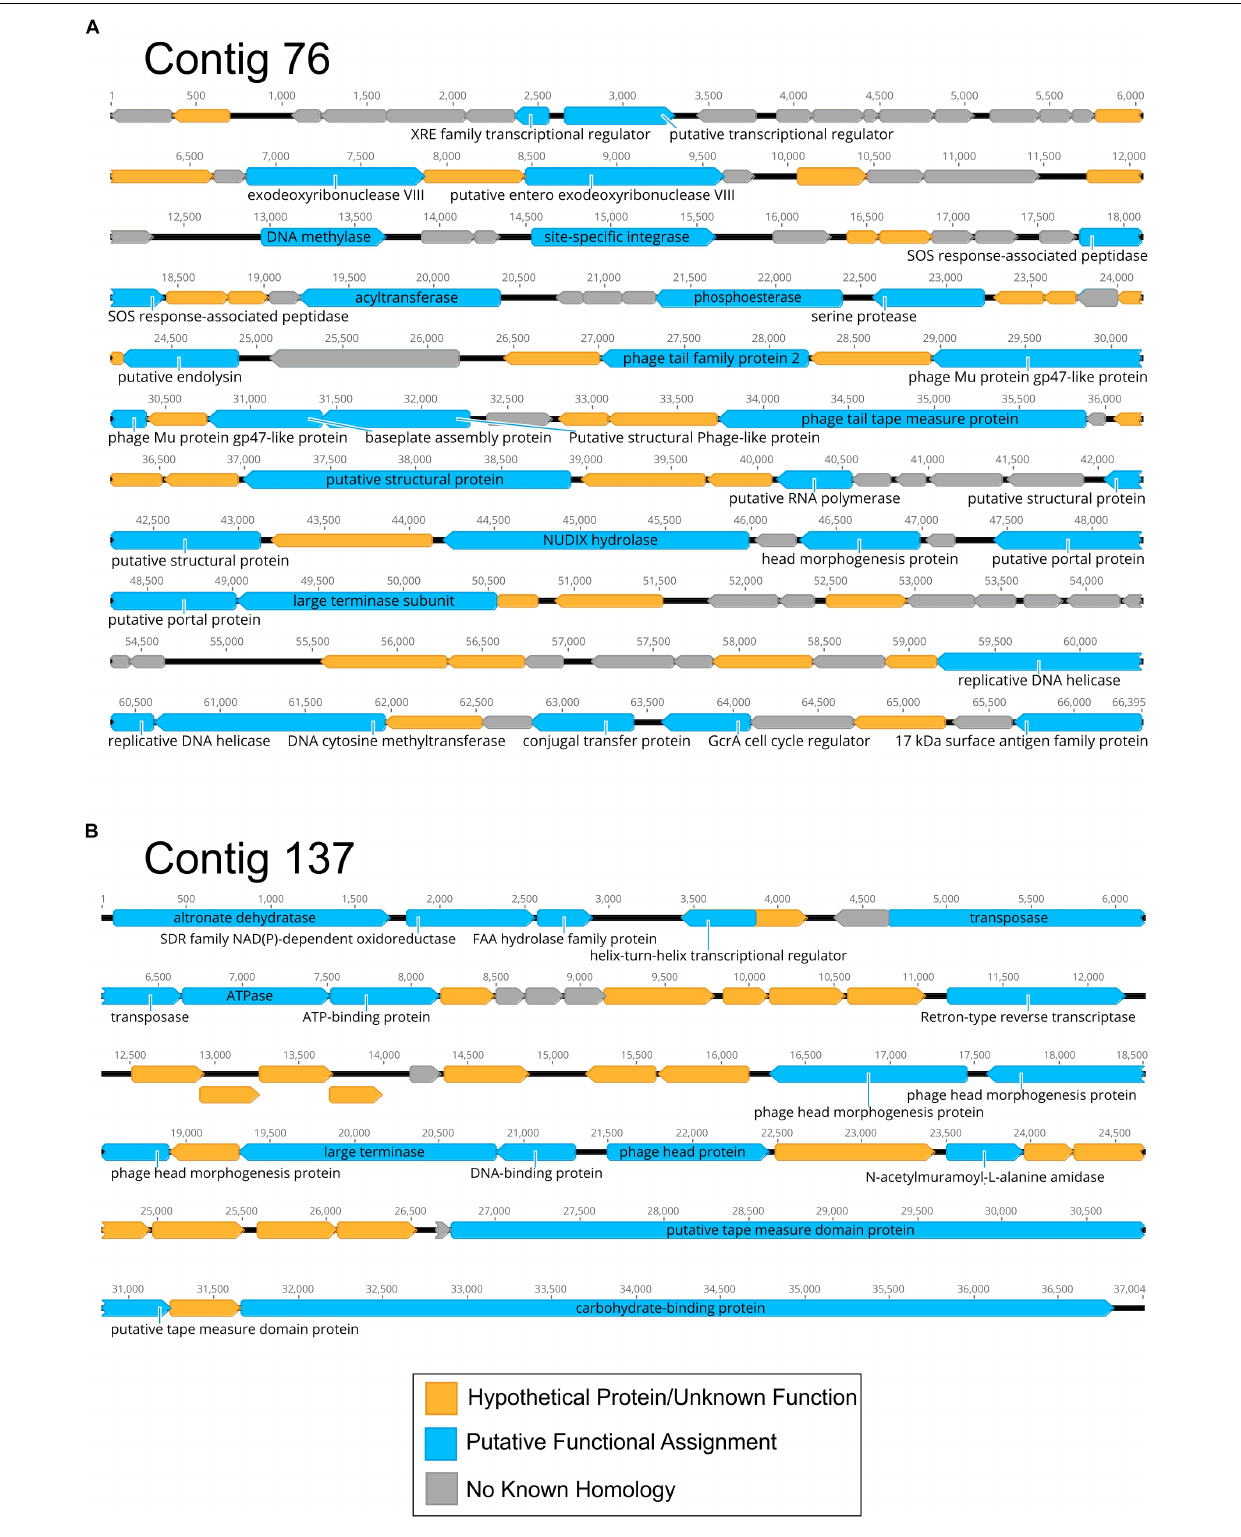
FIGURE 6 | Diagram of Contigs 76 (A) and 137 (B) assembled from CSF viromes of all 20 subjects. Putative ORFs and their direction are indicated by the arrow boxes. ORFs that had significant homologs (BLASTX E < 10 − 5 ) are shown in blue, hypothetical proteins with unknown function are shown in yellow, and ORFs with no known homologies are shown in